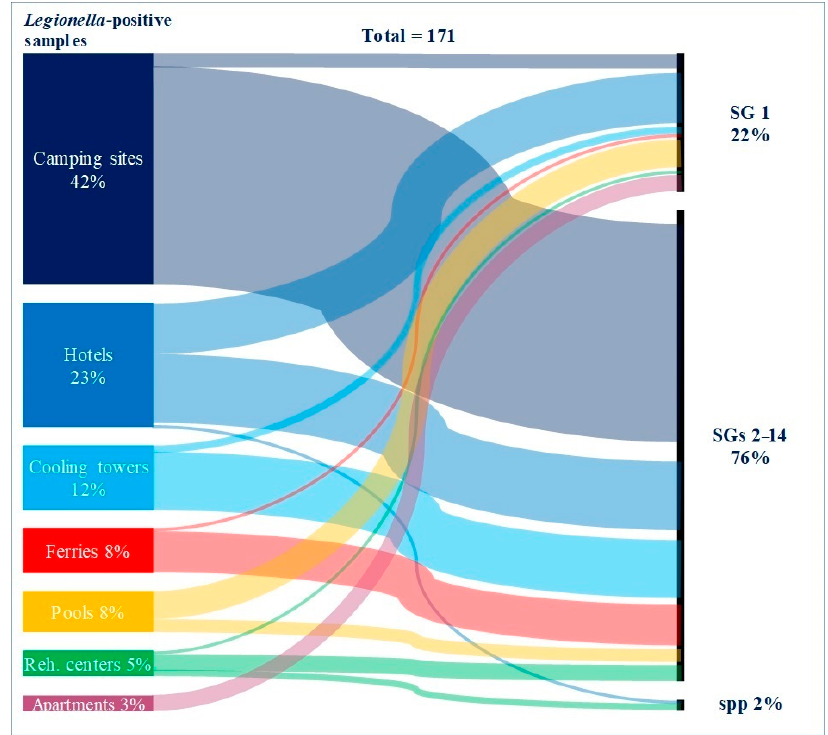
Figure 1. Proportion of L. pneumophila -positive and Legionella spp.-positive samples by facilities with distribution of L. pneumophila serogroups (SG 1 vs. SGs 2–14). The thickness of the color pattern is related to the proportion of Legionella -positive samples.